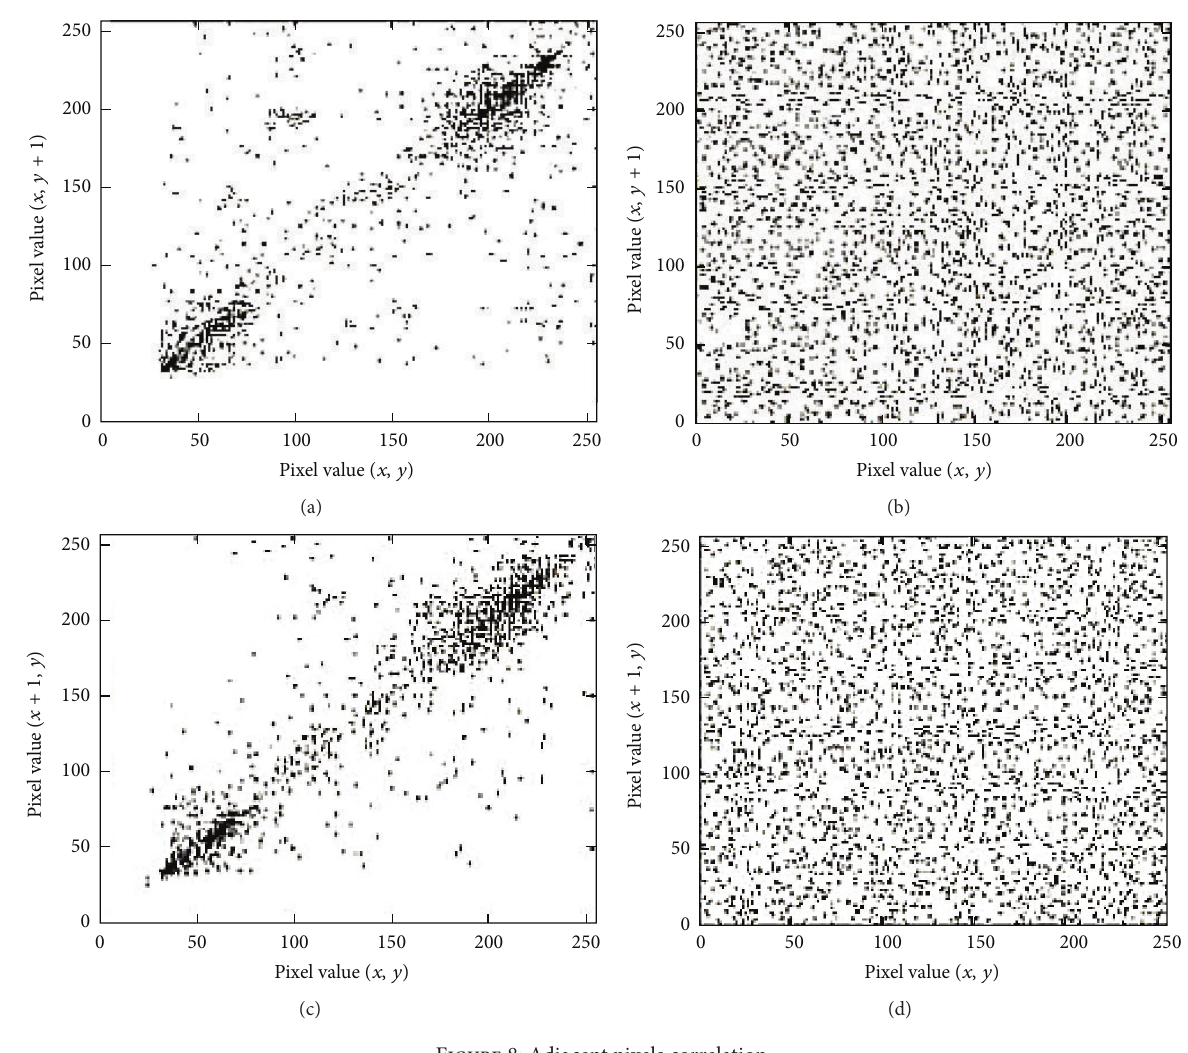
Figure 8: Adjacent pixels